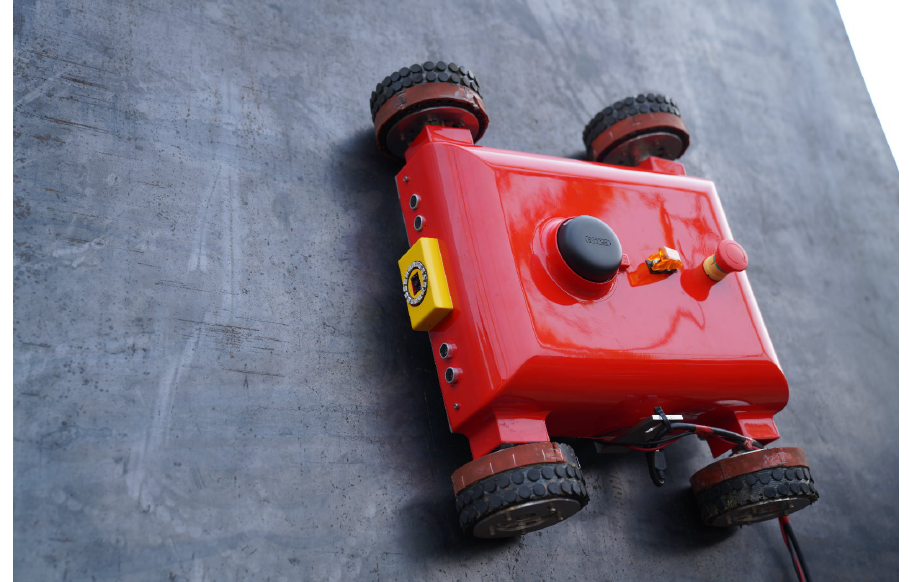
Figure 3. Sparrow robot placed on a metal